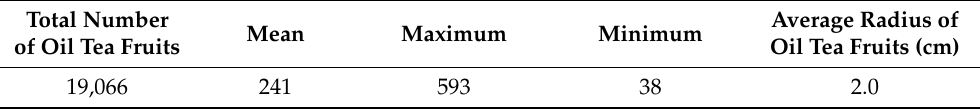
Table 1. Summary statistics of the fruits in oil tea trees in the study area.